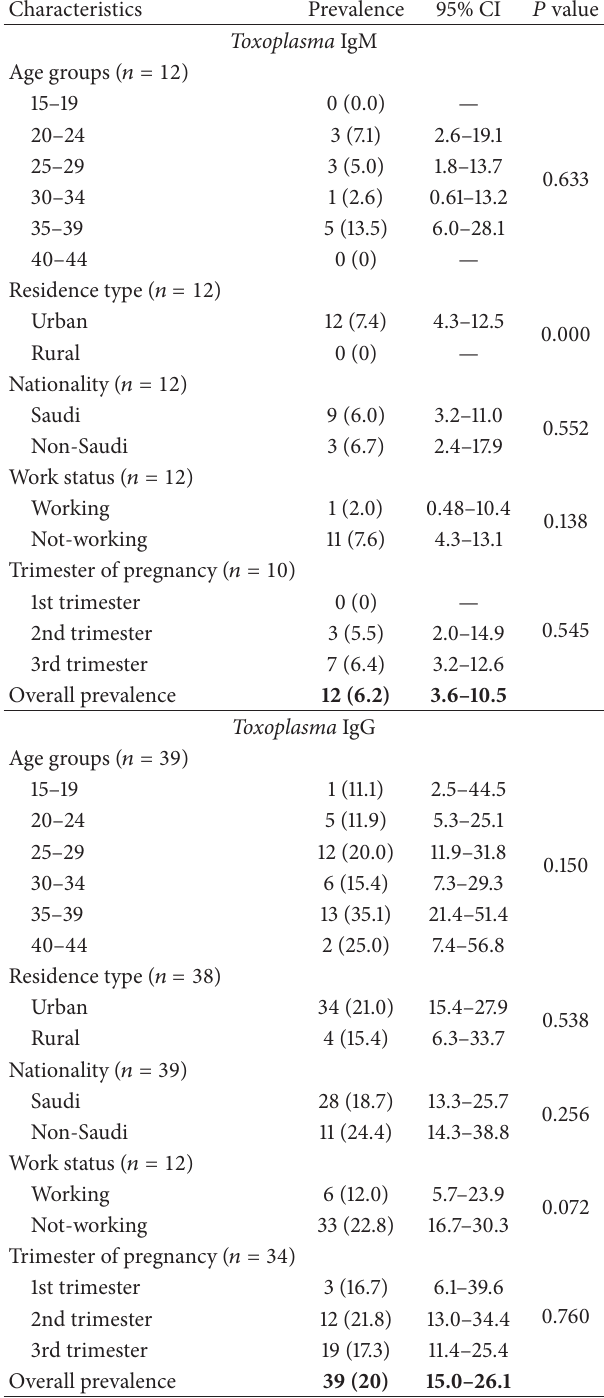
Table 1: Seroprevalence of Toxoplasma IgM and IgG according to selected characteristics ( 𝑛 = 195